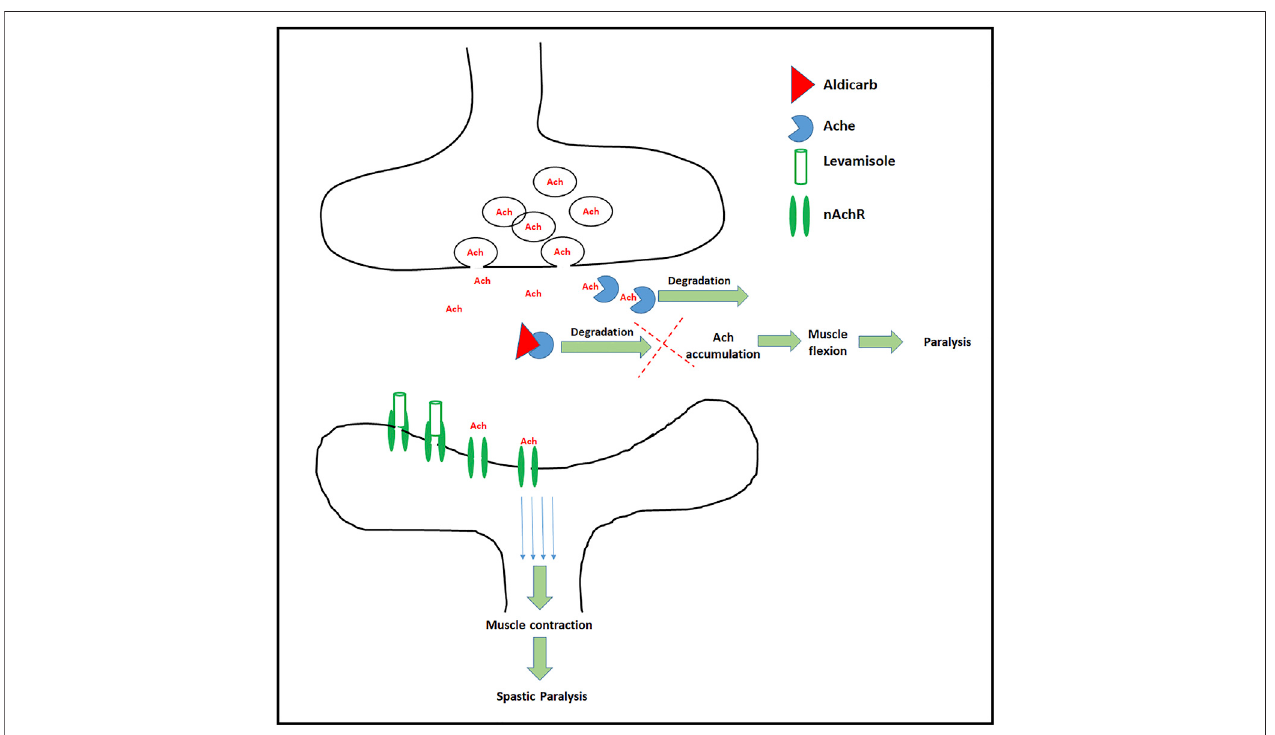
FIGURE 2 | Schematic depiction oftargetsand effectsof Aldicarb and Levamisole: In the normal conditions Ach issynthesized in presynapse, and transported to the synapse. At the synaptic cleft, Ach binds to the Ach receptors (only nAchR shown), which results in the transfer of action potential across neurons. Aldicarb (red triangle)blockstheAchEwhichleadstobuildupofAchcausingmuscle fl exionandparalysis.Ontheotherhandlevamisole,anAchRagonist(transparentcylinder)binds to the nicotinic Ach receptor, ensures continuous action potential culminating in muscle contraction and spastic